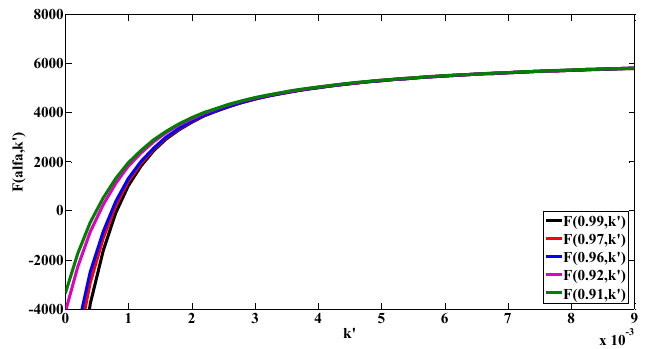
Figure 9. Trend of the function as k’ and α (0.91 to 0.99) changes.